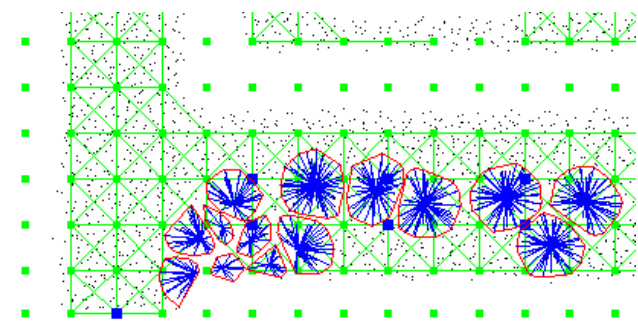
Fig. 12. Bathroom